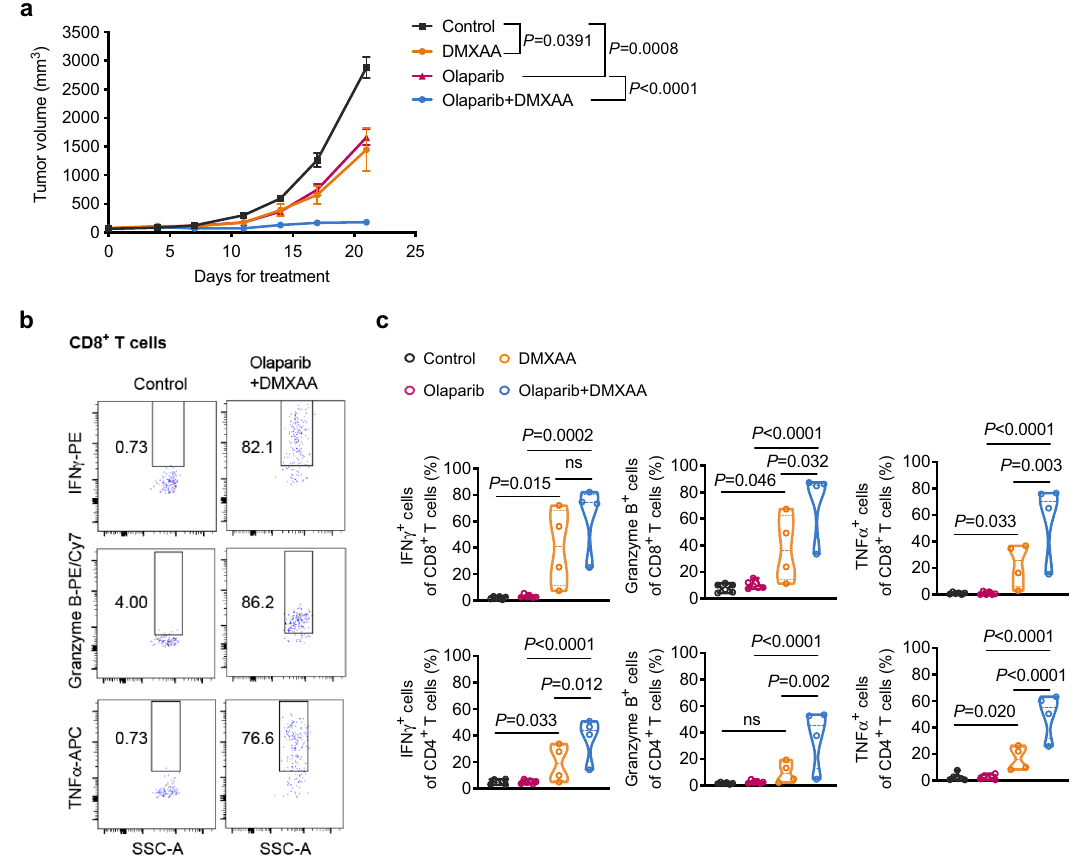
Fig. 5 STING agonists improve therapeutic response of orthotopic BP tumors to olaparib in syngeneic immunocompetent mice in vivo. a BP tumor growth in FVB mice treated with olaparib (50 mg/kg, IP, QD) or intratumoral (IT) injections of DMXAA (10 mg/kg, one dose per week for 3 weeks [total of 3 doses]) as monotherapy or in combination. Control, n = 8; olaparib, n = 9; DMXAA, n = 6; olaparib + DMXAA, n = 7. b and c Analysis of BP tumors after 21 days of treatment for effector cytokine production by intratumoral CD8 + T cells and CD4 + T cells. Flow cytometry plot axes are displayed in logarithmic scale ( b ). Control, n = 6; olaparib, n = 6; DMXAA, n = 4; olaparib + DMXAA, n = 4. Each dot represents data from a single tumor ( c ). Data are presented as mean ± SEM ( a ), or median with quartiles (violin plots, c ). Two-way ANOVA ( a ). One-way ANOVA ( c ). ns, not signi fi cant. Source data are provided as a Source Data fi